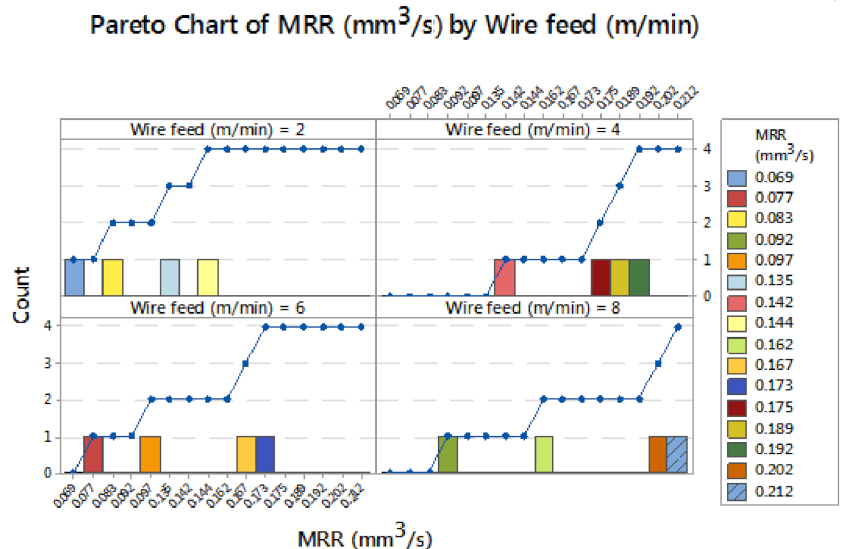
Figure 3. Pareto chart of material removal rate by wire feed rate.